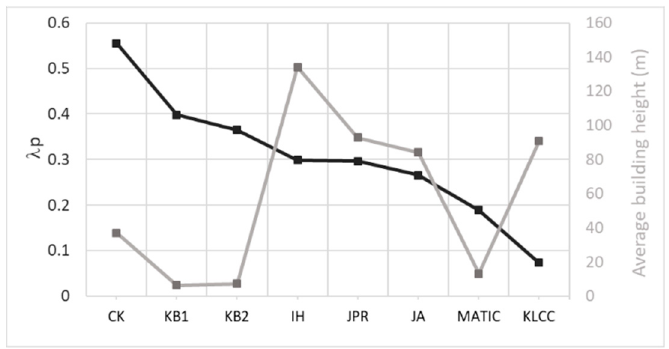
Figure 1. Average λ p and building heights for the monitoring locations within 200 m distance.